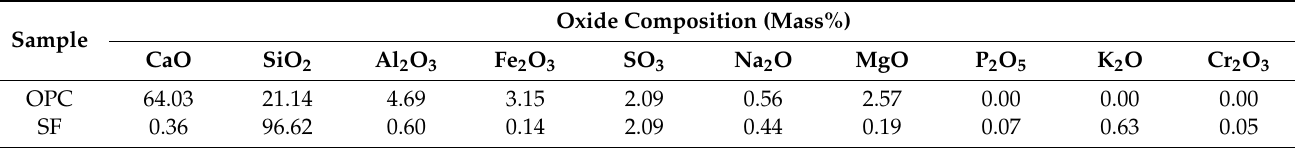
Table 1. Oxide compositions of the Portland cement CEM I 42.5 N and silica fume.